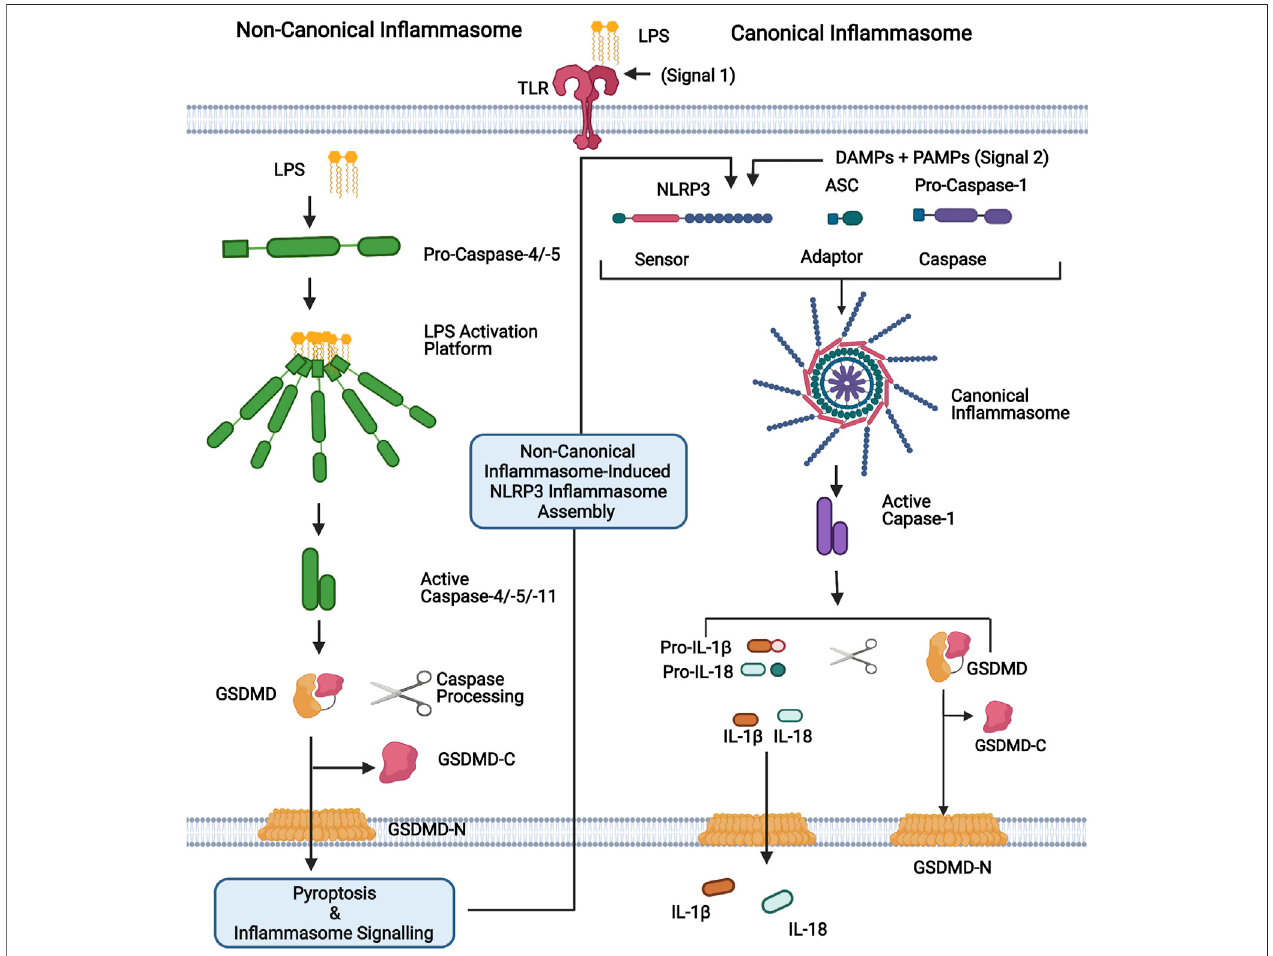
FIGURE 1 | Representation of non-canonical and canonical in fl ammasomes. For the non-canonical in fl ammasome, cytosolic LPS binds directly to the N-terminal CARD domain of caspases-4, -5 (human) or -11 (mouse), leading to their activation. Active caspases-4/-5/-11 cleave their substrate, GSDMD, generating the pore forming N-terminal domain (GSDMD-N). Pore formation allows the secretion of small molecules, including potassium ions, and ultimately leads to pyroptosis. The canonical in fl ammasomeis amultiprotein complexthat forms in response toPAMPs and DAMPs. Itconsists ofa sensor protein (eg. NLRP3 depicted here)and an adaptor (ASC) that facilitates the recruitment and activation of caspase-1. Activated caspase-1 promotes the cleavage ofGSDMD and the in fl ammatory cytokines IL-1 β and IL-18, which are subsequently released via GSDMD-N pores. The non-canonical in fl ammasome promotes the activation ofthe canonical NLRP3 in fl ammasome for in fl ammatory cytokine processing and hence activation of caspases-4,-5 and -11, which are referred to as non-canonical in fl ammasomes. Figure was created using BioRender.